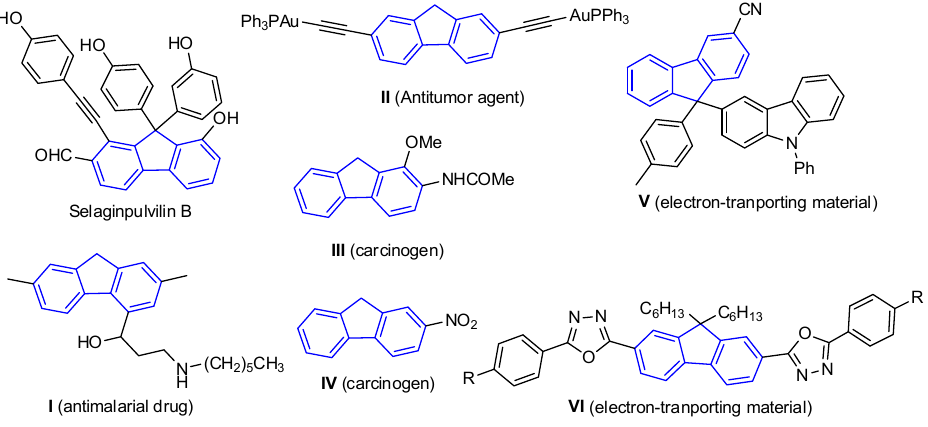
Figure 1. Selected fluorene molecules and their uses.